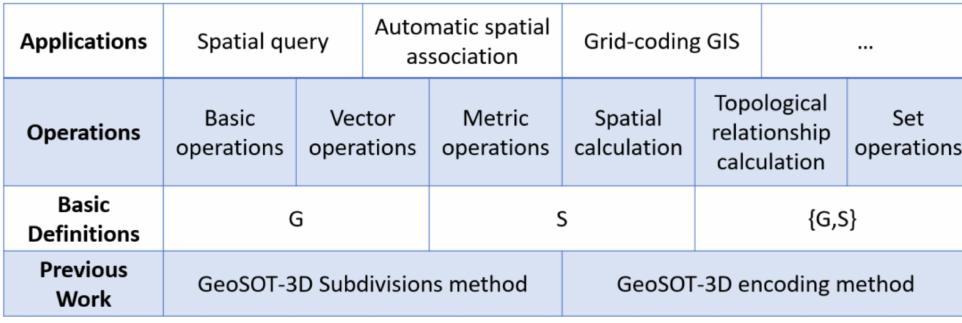
Figure 5. The design of the algebraic operation